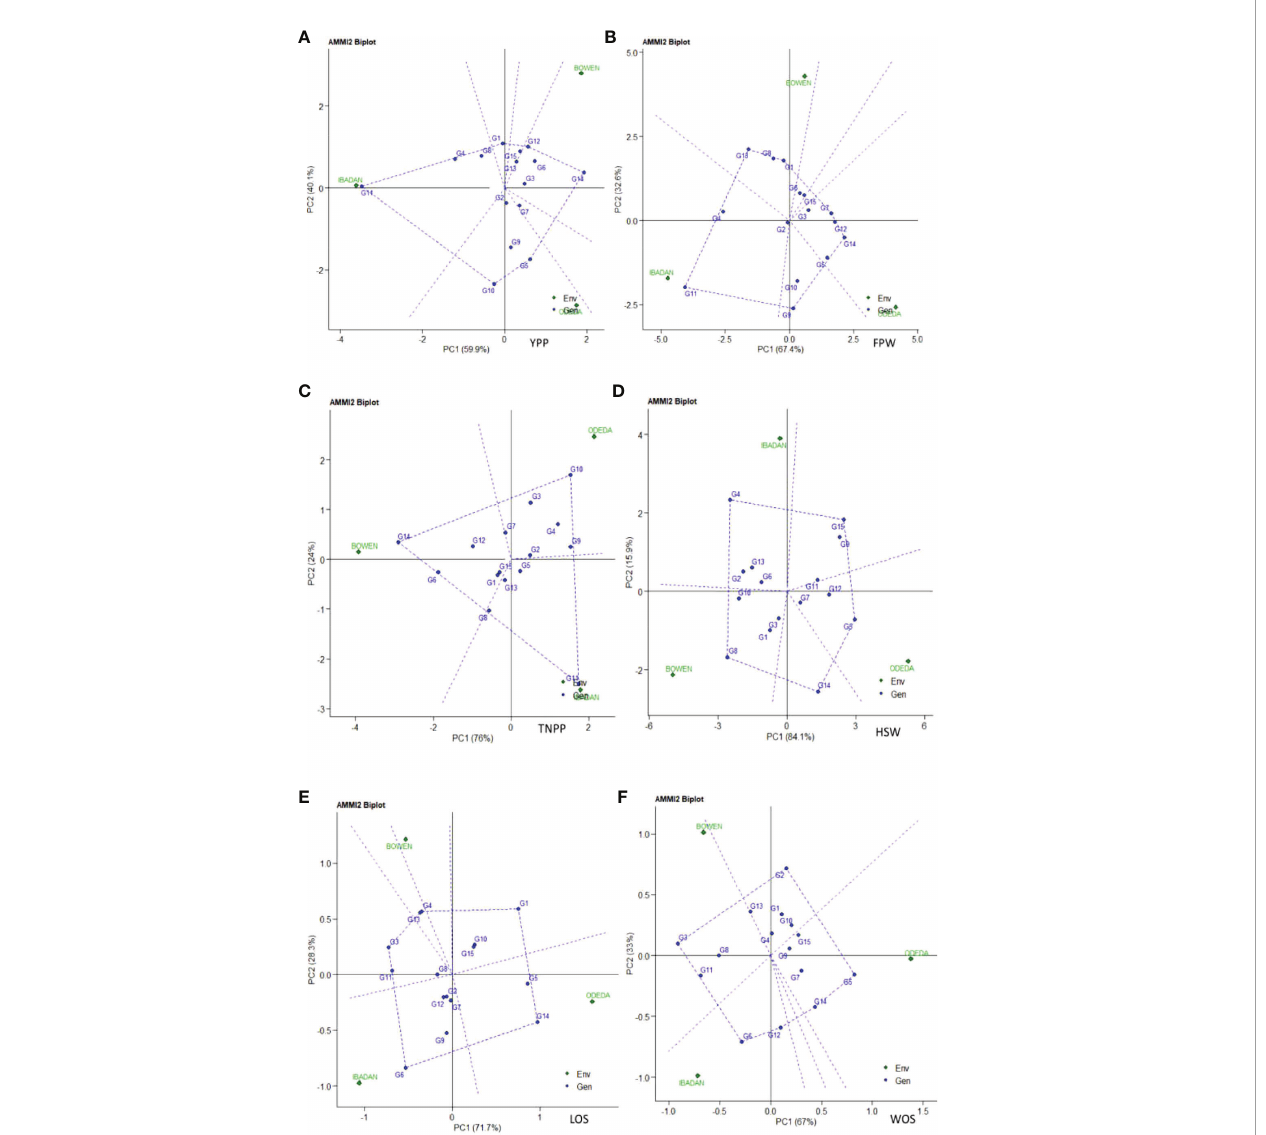
FIGURE 2 Patterns (A – F) . Additive main effects and multiplicative interaction 2 (AMMI 2) biplots based on PC1 and PC2 illustrating G × E interactions of the 15 Bambara groundnut accessions under three sites: (A) yield per plant (YPP), (B) fresh pod weight (FPW), (C) total no. of pods per plant